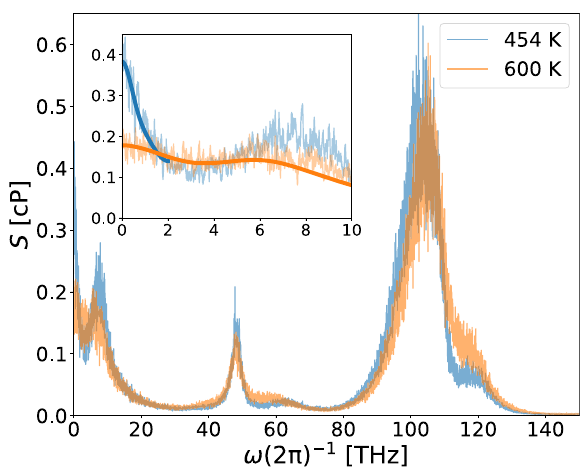
Fig. 1 Ab initio power spectra. Power spectra of the off-diagonal elements of the stress in water at 454 K (blue) and 600 K (orange), obtained from AIMD simulations (see text). The spectra are fi ltered by a moving average with a window of 0.05 THz. The thick solid lines in the inset represent the cepstral- fi ltered spectra whose zero- frequency value gives an estimate of the shear obtained from the cepstral analysis of the power spectrum of the off-diagonal elements of the stress, using the SporTran 73 code. In Fig. 1, we display the (moving averages 74 of the) power spectra of the stress-tensor time series resulting from our two simulations. While showing similar features at high frequency, the two spectra differ substantially approaching ω = 0. In particular, lower temperatures see the appearance of sharp peaks near ω = 0, which requires a greater care in the cepstral analysis of the data, which is based on a low-pass fi lter of the (logarithm of) the power spectra. In the inset, we display the low-frequency region of the spectra together with the results carried out by the cepstral